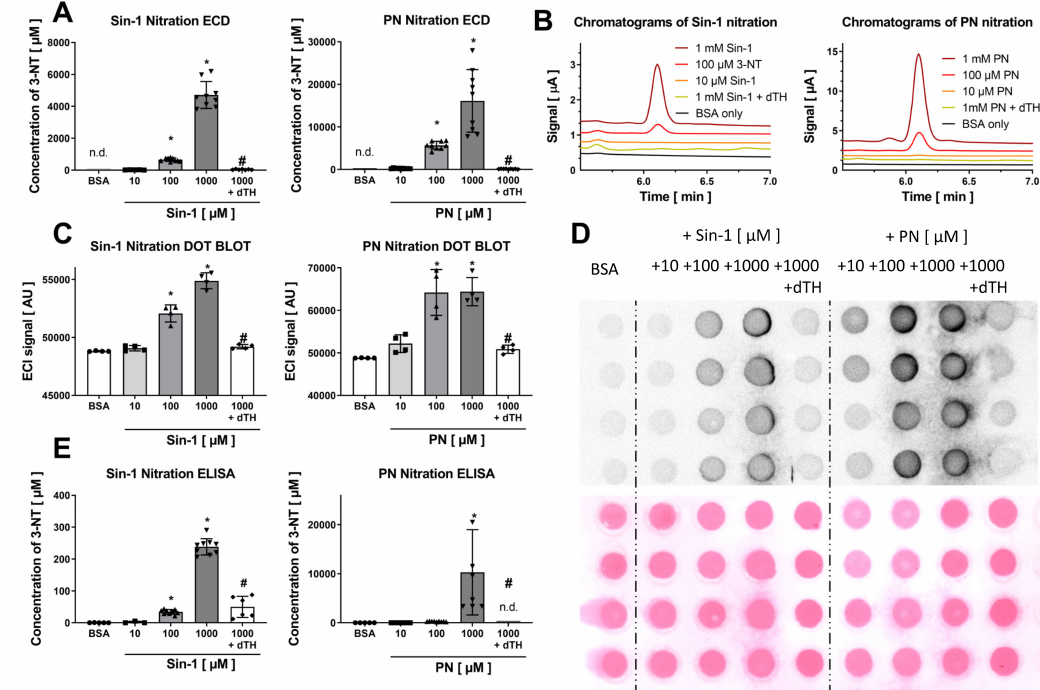
Figure 2. Detection of free 3-NT from nitrated BSA by HPLC / ECD and comparison with detection of BSA-bound 3-NT by antibody-based methods. Purified BSA was nitrated by Sin-1 or PN (10–1000 µ M) and generated 3-NT was reduced by dTH. These samples were subjected to pronase digest before HPLC / ECD analysis ( A ) or were not digested for quantification by dot blot ( C ) and ELISA ( E ). ( B ) Representative chromatograms are shown for the HPLC / ECD quantification. ( D ) Representative blots are shown for the dot blot quantification. Equal protein loading was checked by Ponceau staining of the membrane. HPLC / ECD analysis was performed with 20 µ L of sample at 27 ◦ C with isocratic elution (1 mL / min, mobile phase: 26.3 mM sodium citrate and 10.9 mM sodium at pH 4.75 with 2.8 v / v % methanol; 3-NT eluted at 6.2 min). Data are presented as mean ± SD of n = 9 (A), 9 ( C ) and 4 ( E ) independent experiments. * indicates p < 0.05 versus BSA untreated control group; # indicates p < 0.05 versus 1000 µ M Sin-1 / PN